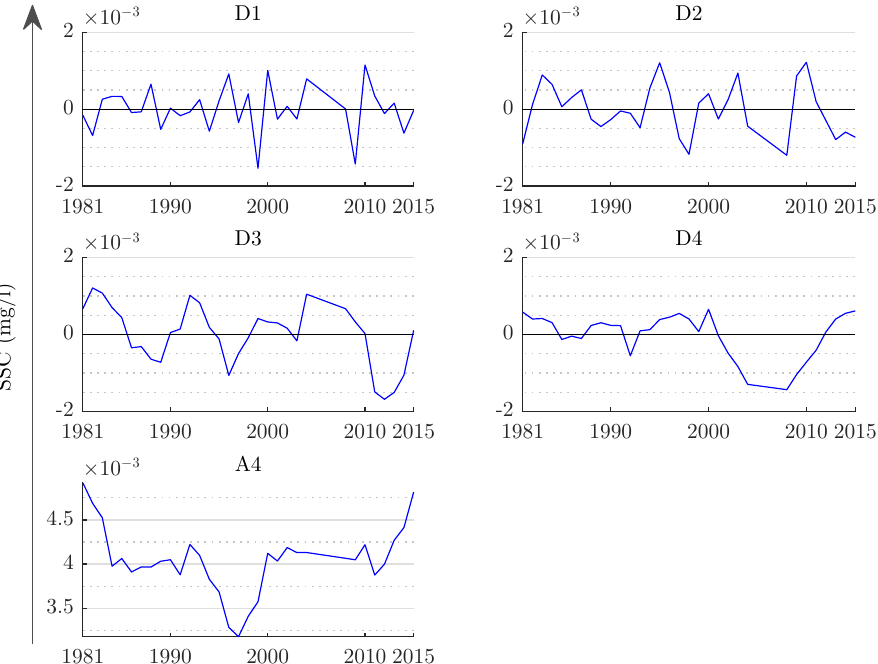
Figure 4. Detailed coefficients of (DW1) two years, (DW2) four years, (DW3) eight years, and (DW4) sixteen years along with approximation coefficient (A4) of Dainyor. The figure shows that a change in magnitude of high and low SSC remains the same.